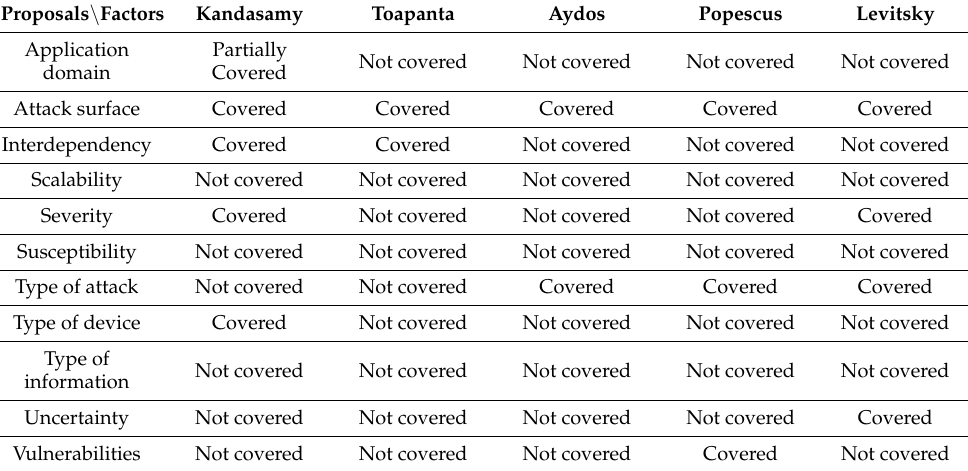
Figure 6. Concurrence-Table option of Atlas TI to identify the relationships between codes. Table 4. Analysis of the factors of IoT devices that are covered by the proposals of IoT risk methodologies.